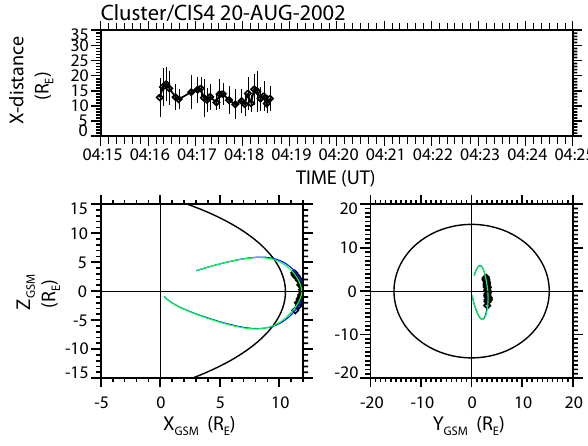
Fig. 7. Top: altitude of injection from the C1 position deduced from the low energy cut-off of the ion dispersion. The first dispersion is marked with open diamonds and the second one with green dia- monds. Bottom left: position of the injection in X − Z GSM along the Tsyganenko 1996 field lines. In blue for the first dispersion and in green for the second. The magnetopause (Petrinec and Rus- sell, 1996) is shown as a black line. Bottom right: same as left in Y − Z GSM . The T96 model uses the Sibeck et al. (1991) magne- topause model which scales self-similar with pressure, while the Petrinec and Russell (1996) model also considers IMF B z . Under certain circumstances, the differences in the models can result in a Tsyganenko magnetic field line to be located outside the model magnetopause location.